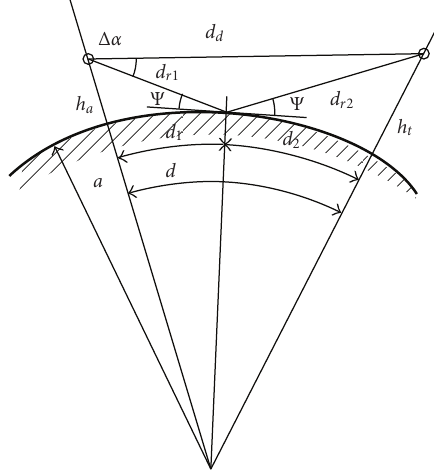
Figure 2: Multipath problem for an antenna (left) and a target (right) above a spherical sea surface.